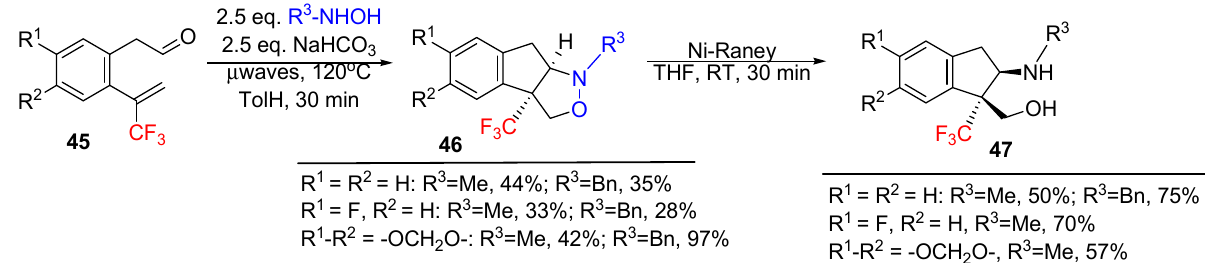
Scheme 26. Synthesis of 1-CF 3 -aminoindanes 47 from compounds 45 by intramolecular 1,3-dipolar nitrone cycloaddition followed by reduction with Raney Ni.